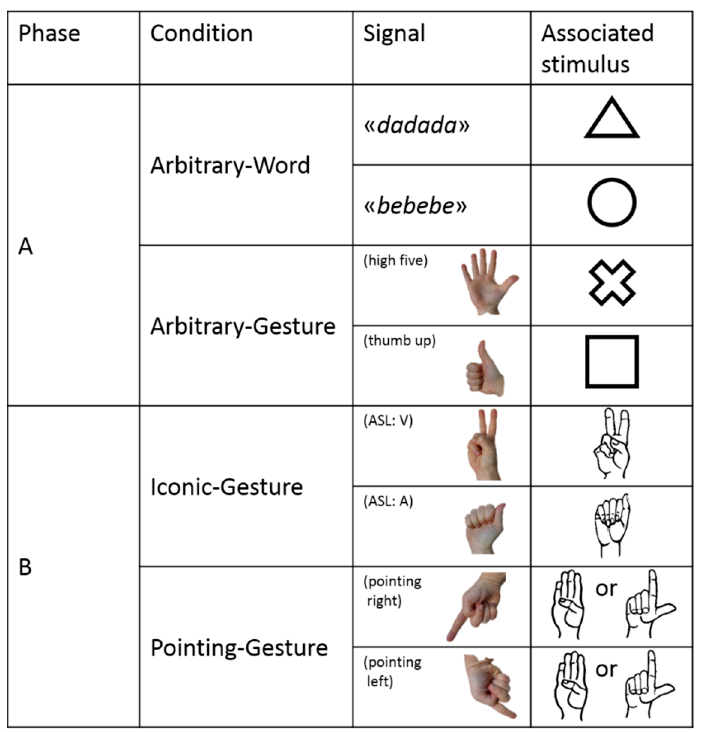
Figure 4. Signals and associated stimuli used for each phase and condition of Experiment 2.